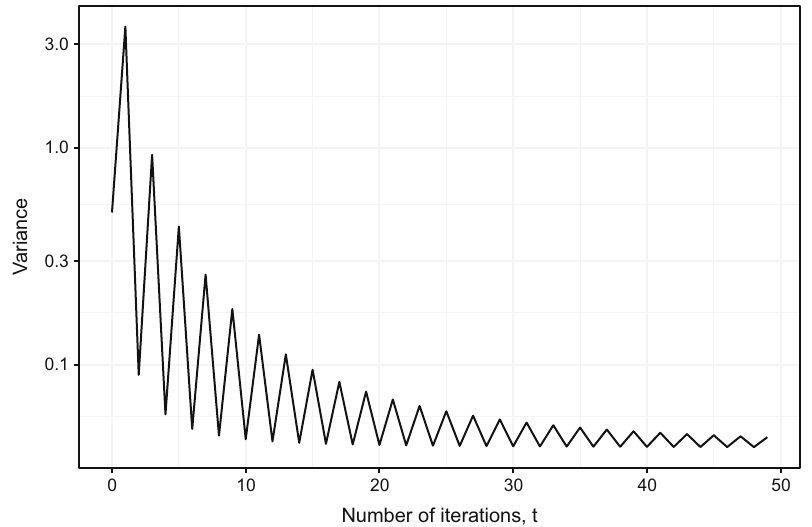
Figure 2: The variance of μ ˆ t ( ) as a function of t . Although a single iteration may increase the variance, we observe that, in this simulation, every two iterations reduce variance. The data here are generated from the normal model ( 18 ) in Section 5 with n 100 = , ρ 0.1 = , and μ −1 =